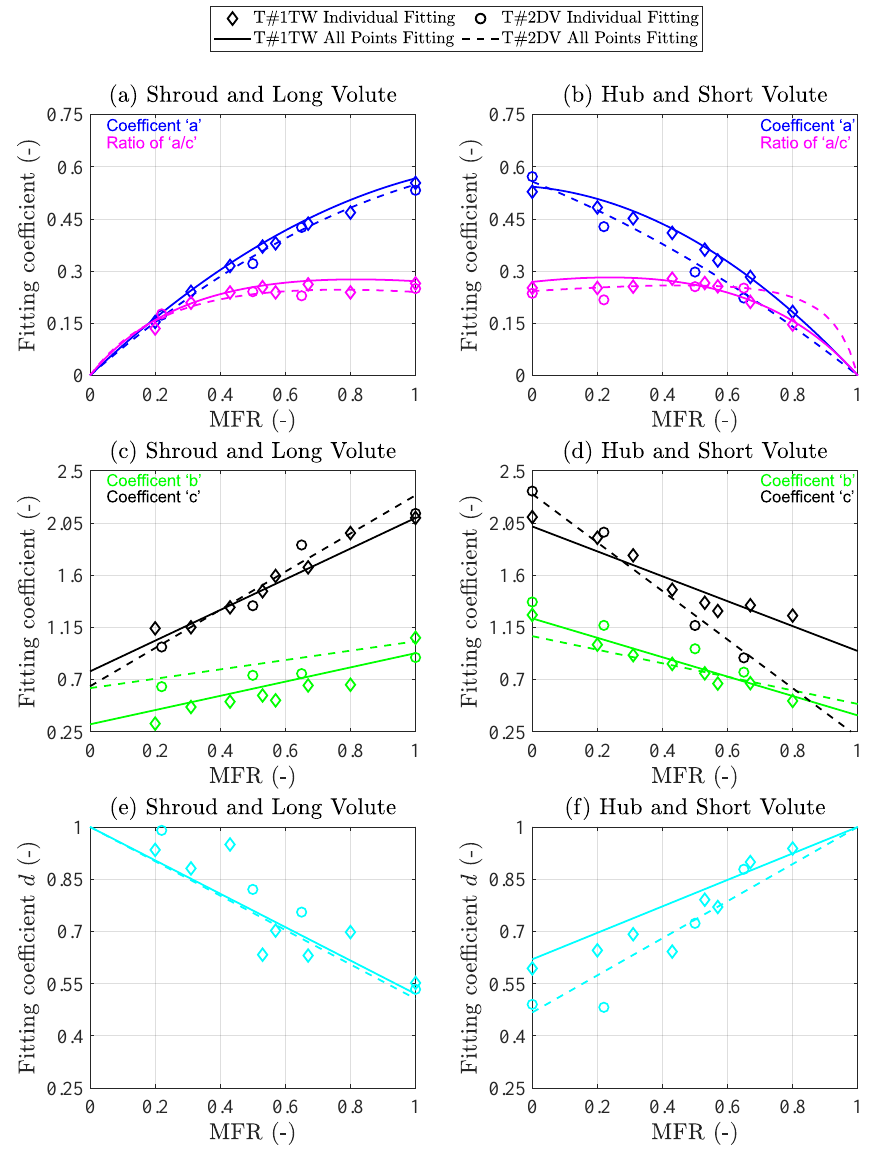
Figure 12. Reduced mass flow coefficient trends obtained using a global fitting procedure. Trends are imposed and all MFR s are fitted at the same time. The coefficients from individual MFR fittings are also shown for